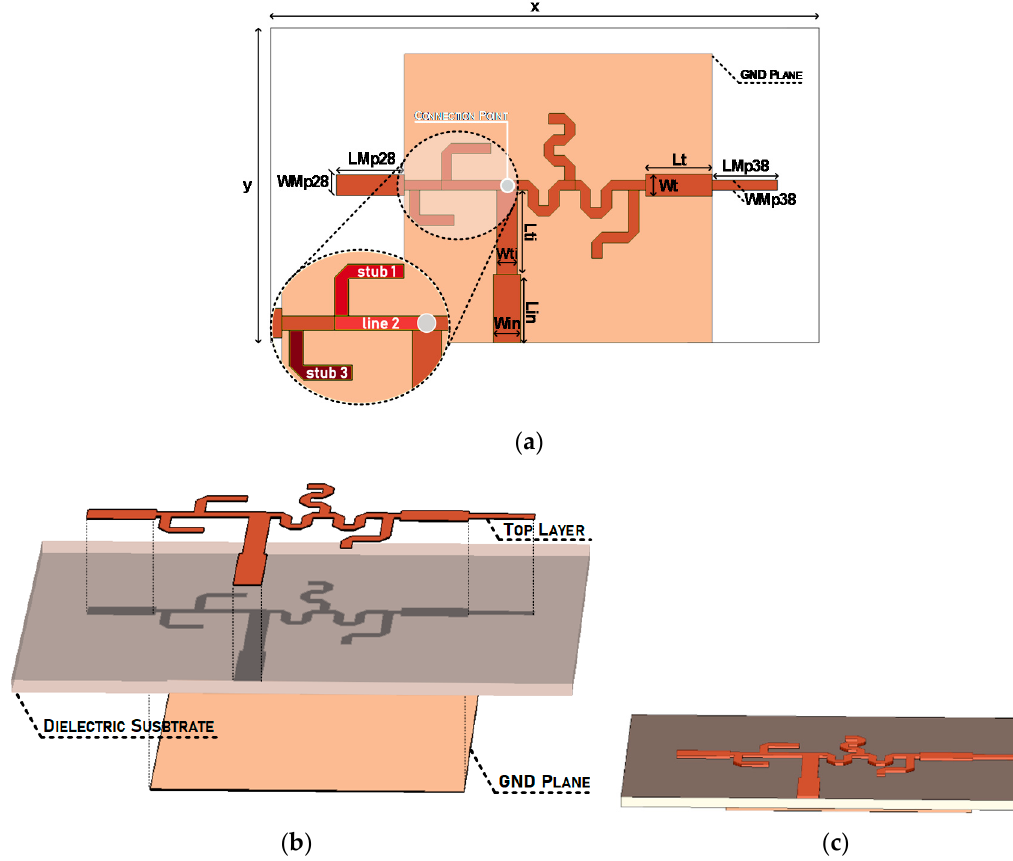
Figure 4. Dual-Band Antenna: ( a ) Design Parameters, ( b ) Layers Identification and ( c ) Final Structure. After bearing all theoretical propagation considerations, the dual-band antenna optimized design parameters are presented in Table 1 and the feeding network line width is constant throughout the antenna (0.2 mm), with the exception of the quarter-wavelength transformer ( Lti × Wti) and the 50 Ω input line ( Lin × Win ), connected to the single feeding point. Table 1. Dual-Band Antenna’s